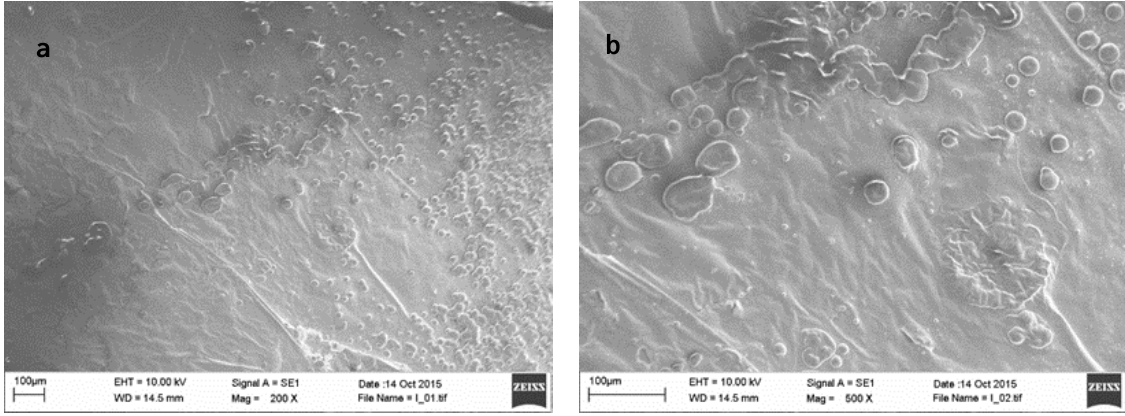
Figure 2. ’Florina’ peel segment at 200x (a) and 500x (b) magnifications before storage.